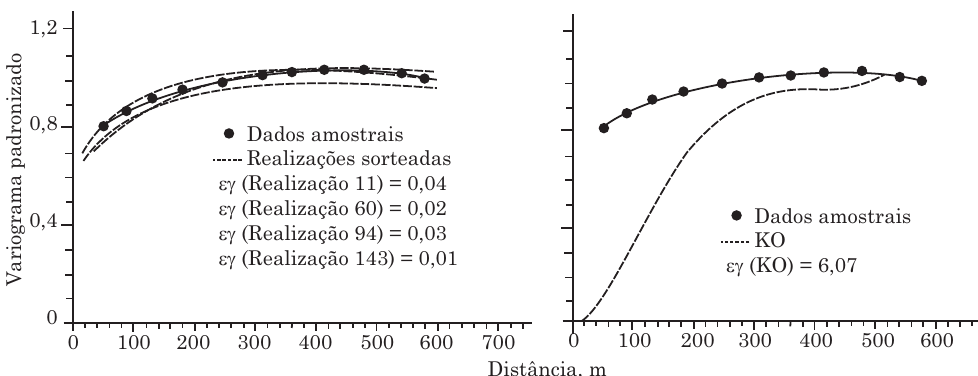
Figura 9. Variogramas padronizados do fósforo lábil e erro na reprodução do variograma εεεεε